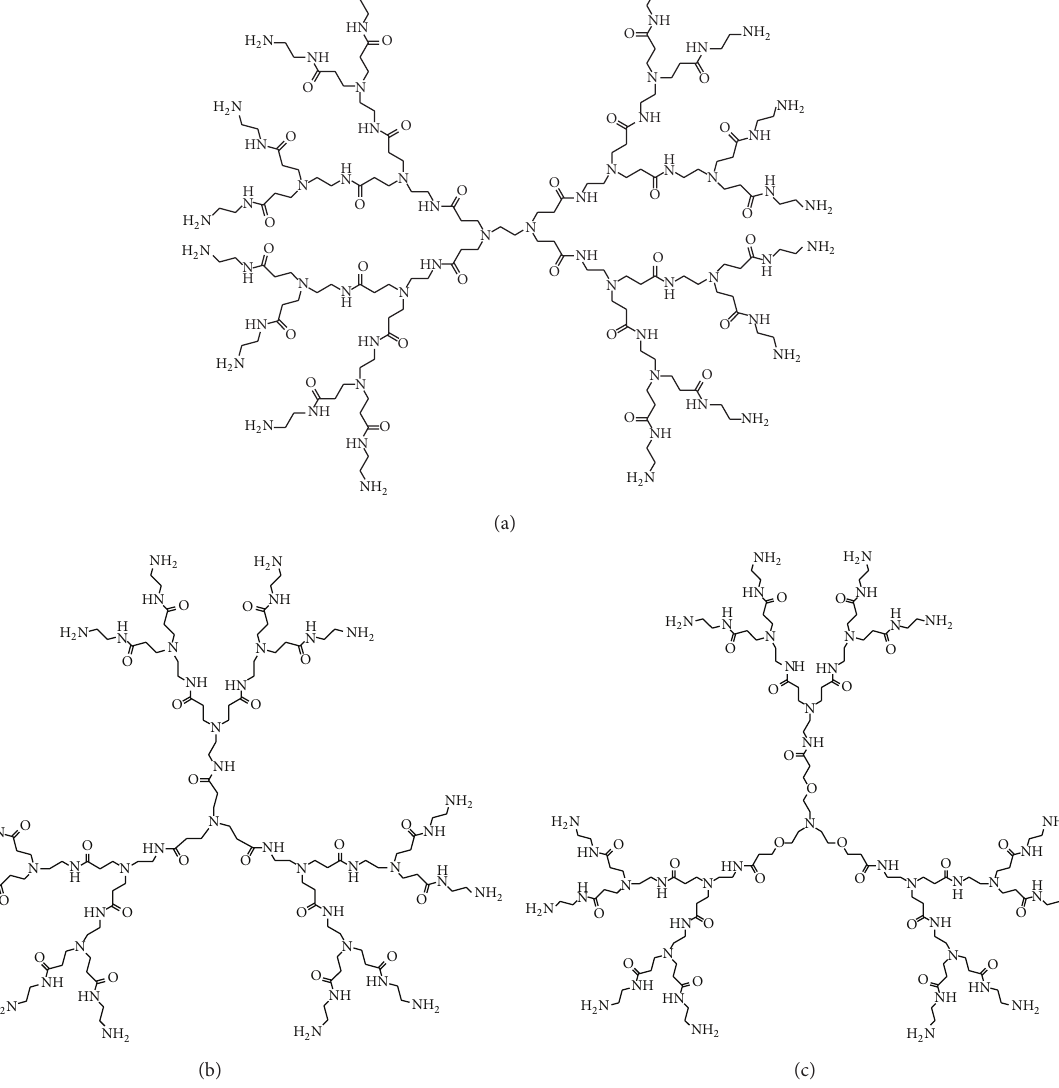
Figure 3: Molecular structure of generation 2 PAMAM dendrimer with (a) ethylenediamine (EDA) core, (b) ammonium (NH 3 ) core, and (c) triethanolamine (TEA)